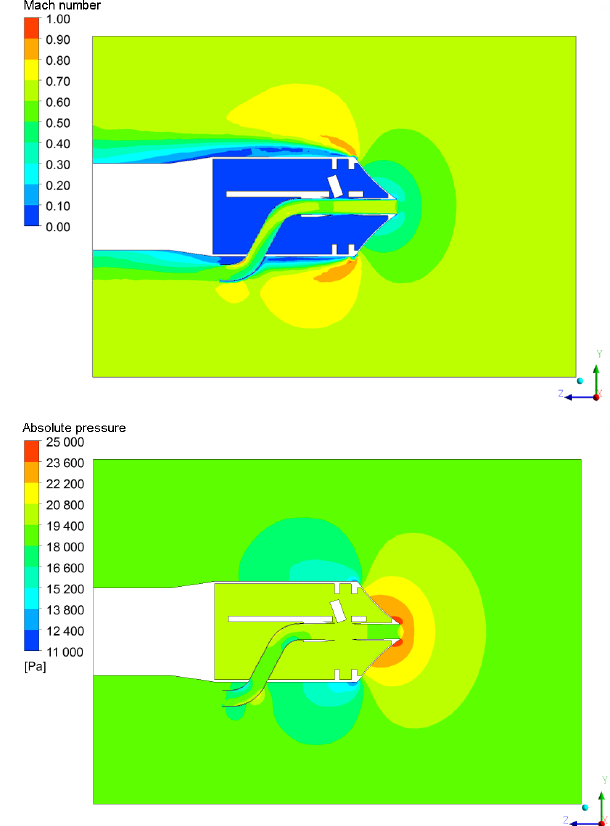
Figure 5. Mach number distribution (upper panel) and pressure dis- tribution (lower panel) of the flow field inside and outside the